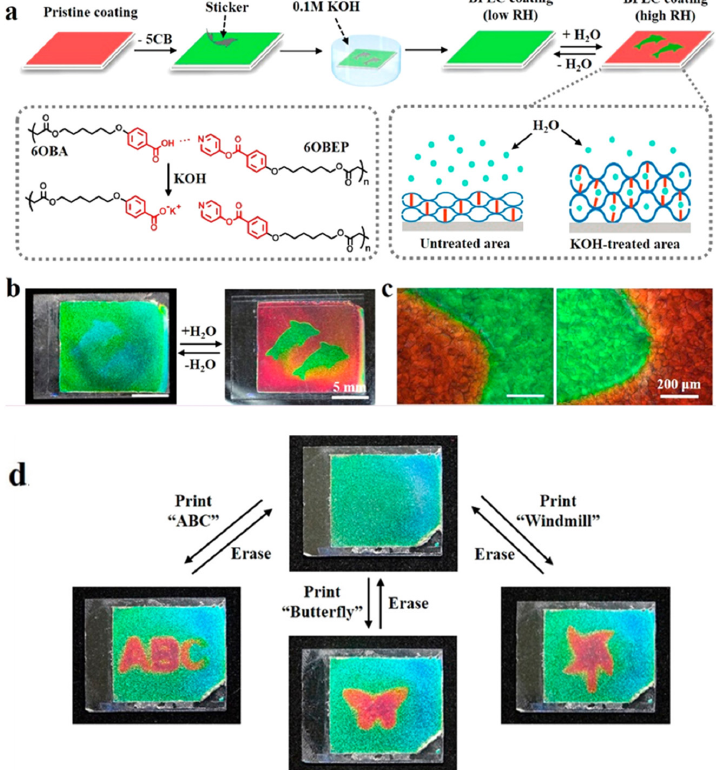
Figure 14. ( a ) Schematic diagram of BPLC pattern information encryption. ( b ) Input and erasure of pattern information. ( c ) POM images of humidity-driven BPLC film. ( d ) Printing and erasure of inkjet printing patterns [116]. Bioinspired Color-Changing Photonic Polymer Coatings Based on Three-Dimensional Blue Phase Liquid Crystal Networks from Wang, Appl Mater Interfaces, published by American Chemical Society.